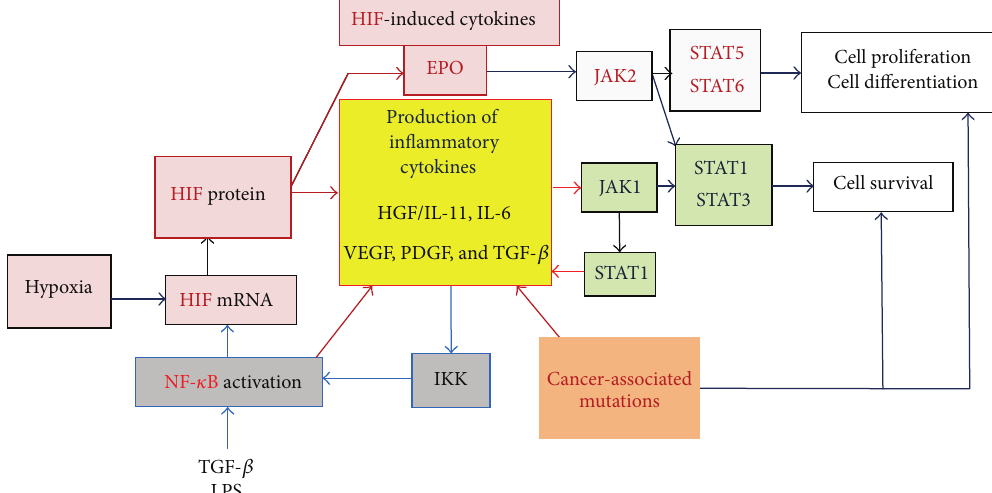
Figure 3: Main molecular pathways activated for the production of inflammatory cytokines. Three main transcription factors control the production of inflammatory cytokines and subsequently cell survival and proliferation: (i) HIF-1 𝛼 , activated in hypoxic tissues, regulates the transcription of multiple genes including numerous inflammatory cytokines and growth factors that promote cell survival, fibrosis, and neoangiogenesis [12, 13]; (ii) NF- 𝜅 B induces the expression of many inflammation cytokines and growth factors, as well as HIF-1 𝛼 mRNA; (iii) STAT1, like NF- 𝜅 B, induces the expression of several inflammation cytokines. To a lesser degree, STAT3 also regulates cytokine transcription, notably of IL-6. STAT1 and STAT3 are activated by JAK kinases, essentially JAK1, but other kinases also activate STAT transcription factors (e.g., MET, the HGF receptor). In addition, cancer-associated mutations may affect the expression ( TET2 and IDH1/2 mutations) or signaling ( JAK2 -V617F, CBL , or LNK mutations) of cytokines or cytokine receptors. Certain growth factors (TGF- 𝛽 ) and other molecules such as liposaccharide (LPS), a component of Gram-negative bacteria, can also activate the NF- 𝜅 B pathway and subsequently the HIF and JAK/STAT pathways. Red arrows represent pathways that directly lead to increased production of inflammatory